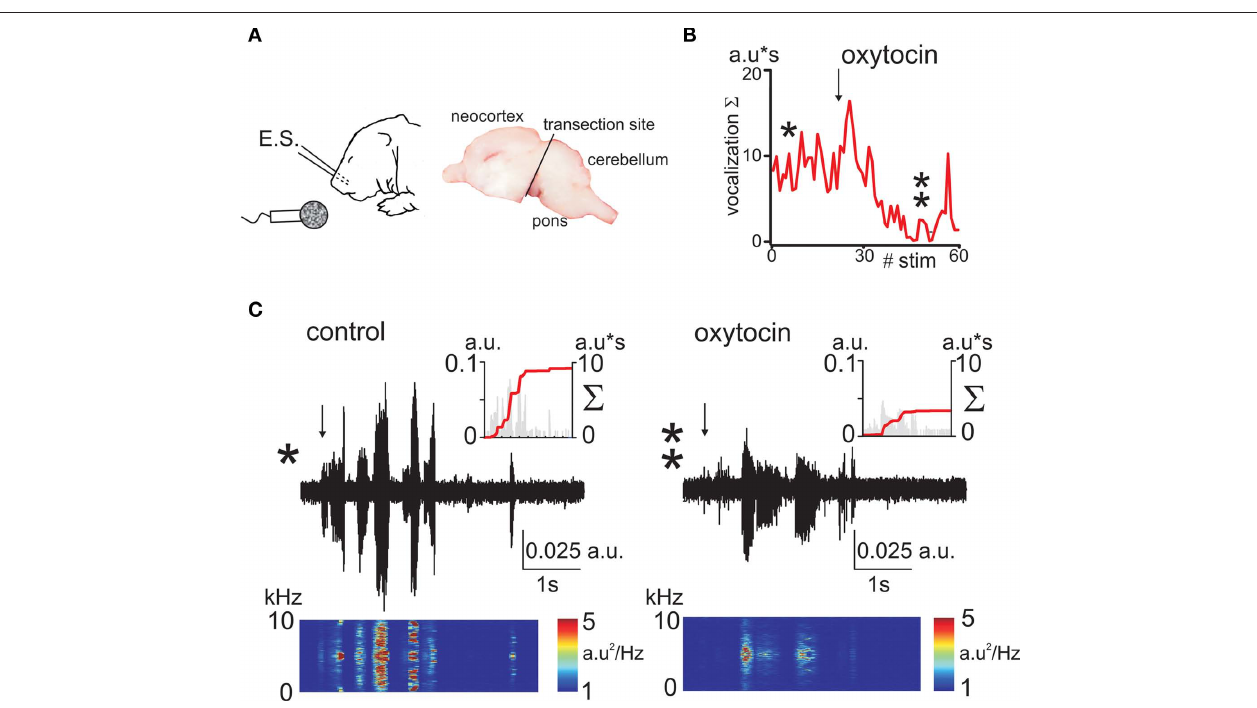
(a.u = arbitrary unit). (C) Sonogram of the electrostimulation evoked vocalization in P1 pup in control conditions (left trace) and 20 min after administration of oxytocin (1 µmol/kg, i.p.; right trace). Spectrograms of the vocalization responses are shown under each trace. Insets show corresponding scalar vocalization response (gray bars, left ordinate) and scalar vocalization integral (red line, right ordinate).